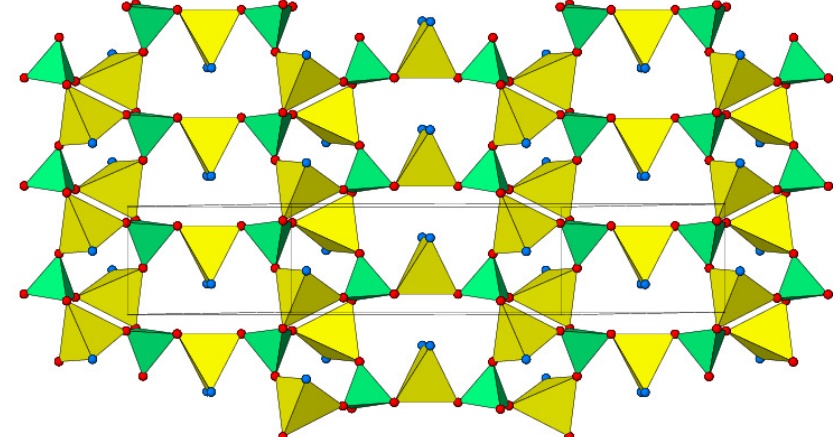
Figure 2. Part of a (100) tetrahedral sheet in 1 . Color key: Zn tetrahedra yellow, P tetrahedra green, O atoms red, N atoms blue.